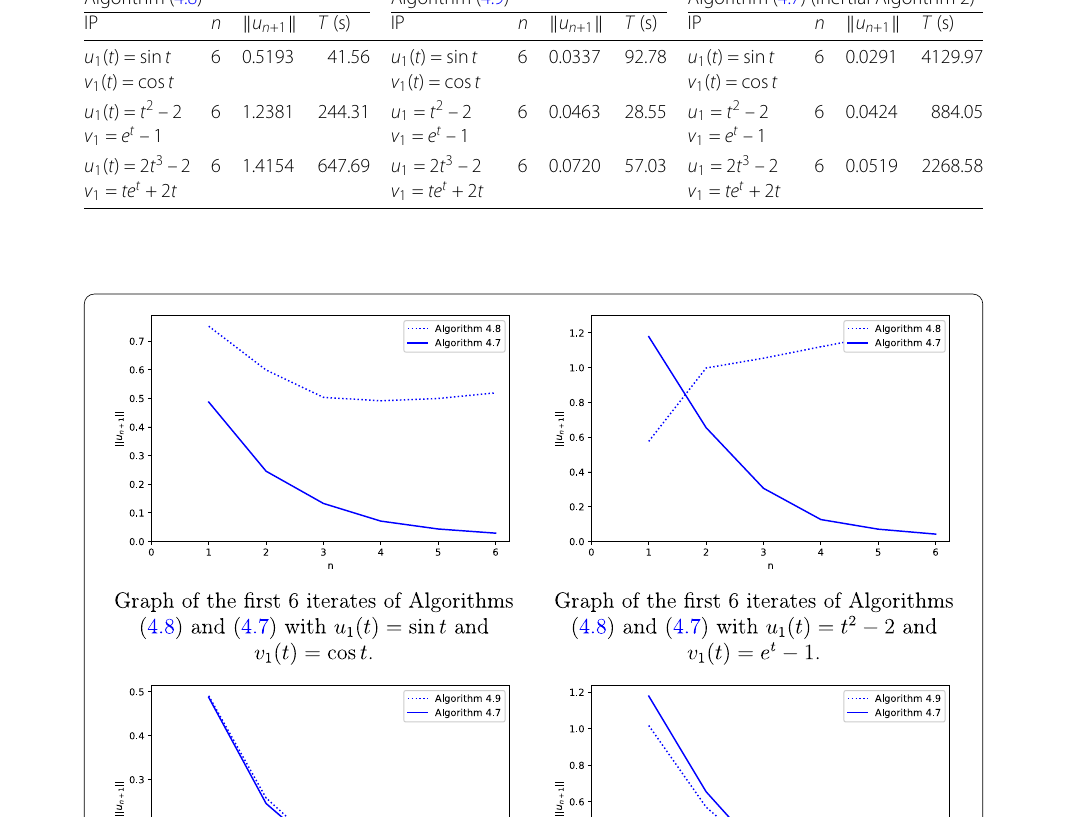
Table 3 Numerical results for Example 2 Algorithm